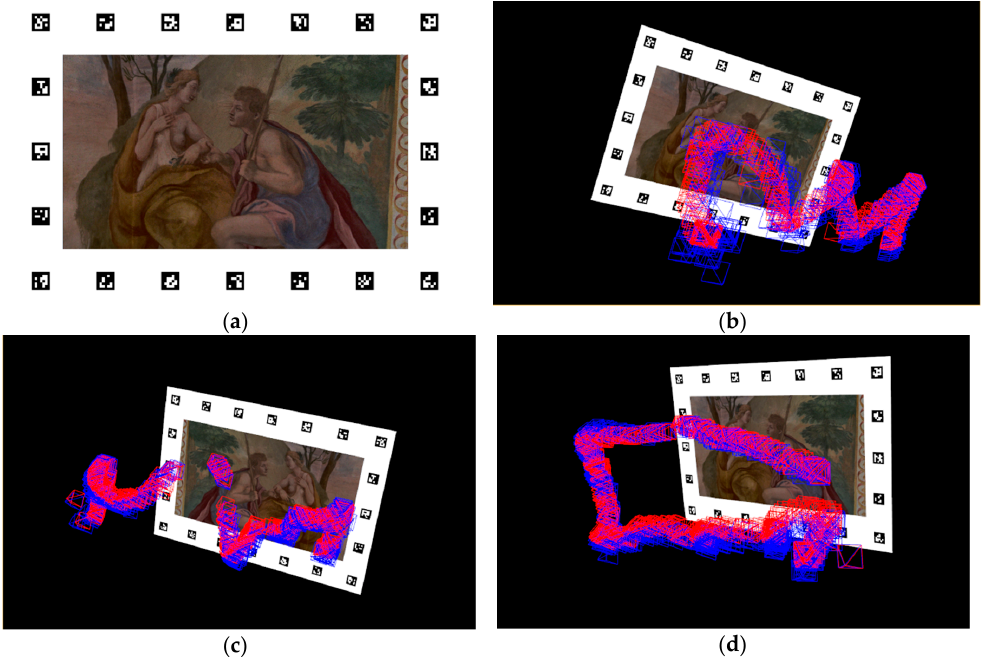
Figure 13. Algorithm evaluation of the Al Fresco Cabinet. ( a ) Poster used to test the accuracy. ( b–d ) Camera poses in each sequence (red—ground truth; blue—our method).